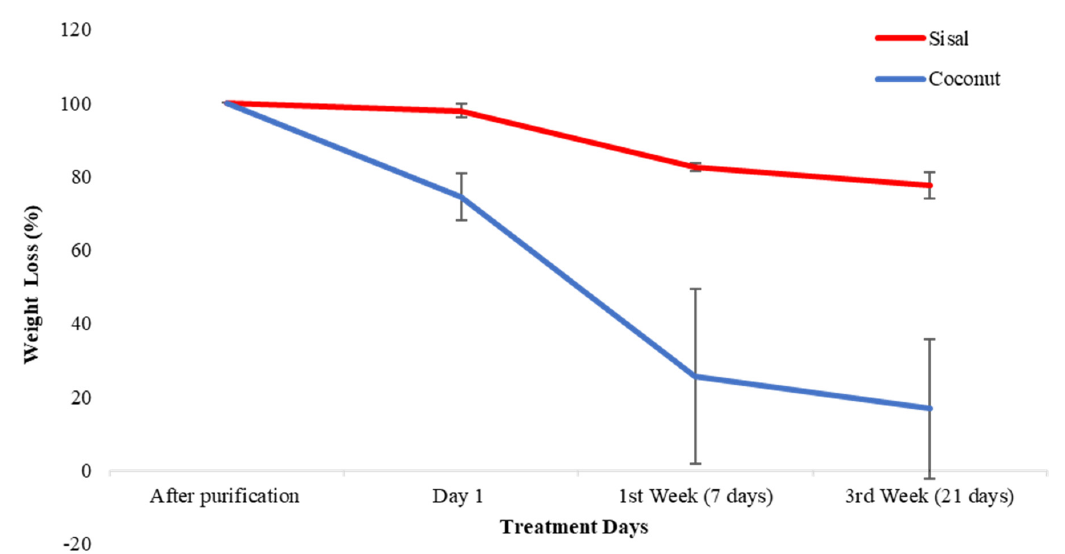
Figure 6. Average of percentage weight loss of coconut and sisal fibers in a period of three weeks of incubation in water at 37 °C. The degradation of the coconut has an accelerated behavior, but stabilizes in the third week; the sisal fibers are more constant in their degradation.